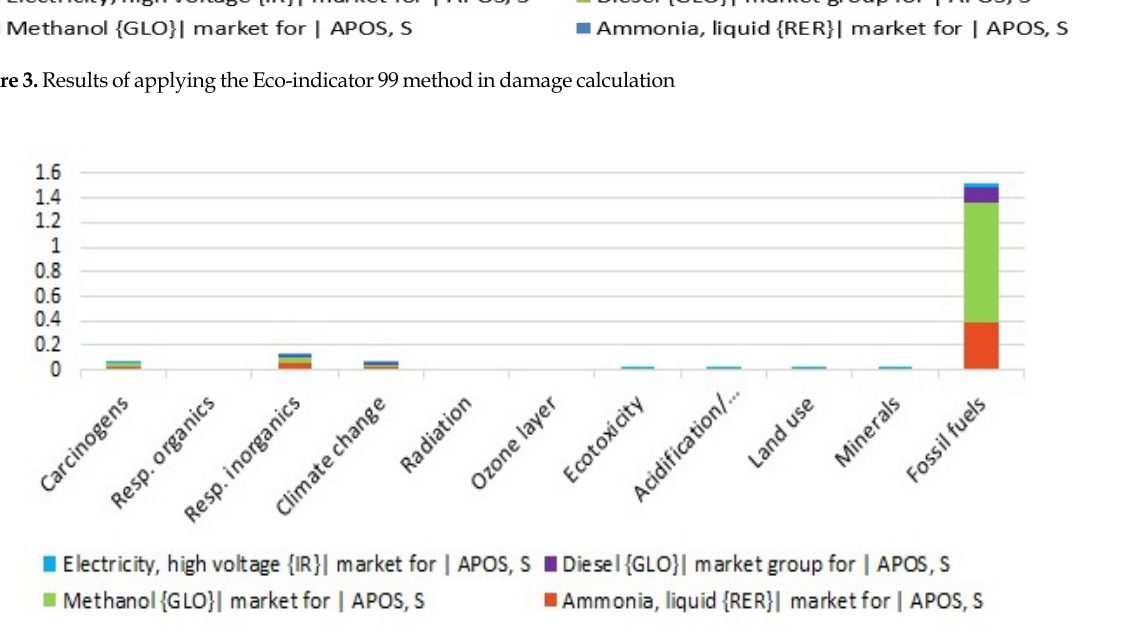
Figure 4. Results of applying normalization coefficients of the Eco-indicator 99 method in calculating impacts